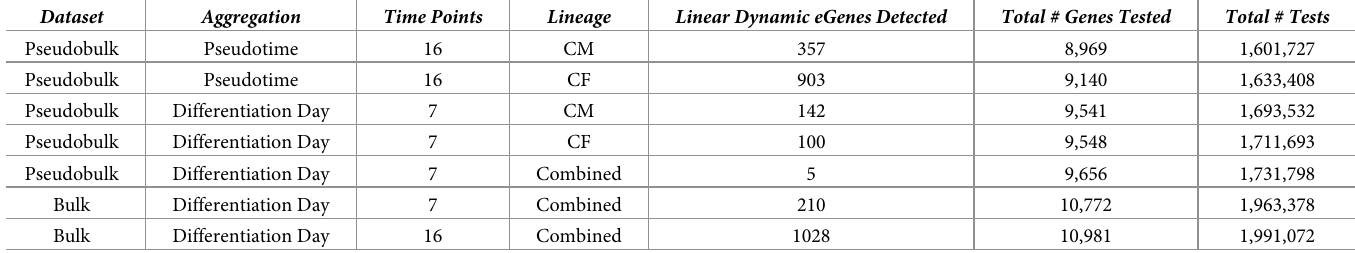
Table 1. Comparison of linear dynamic eQTL calling methods. We report the number of linear dynamic eGenes (genes with a significant dynamic eQTL at gene-level q-value < = 0.05), for each of the aggregation schemes assessed. Total number of genes tested and total number of tests run are also reported.